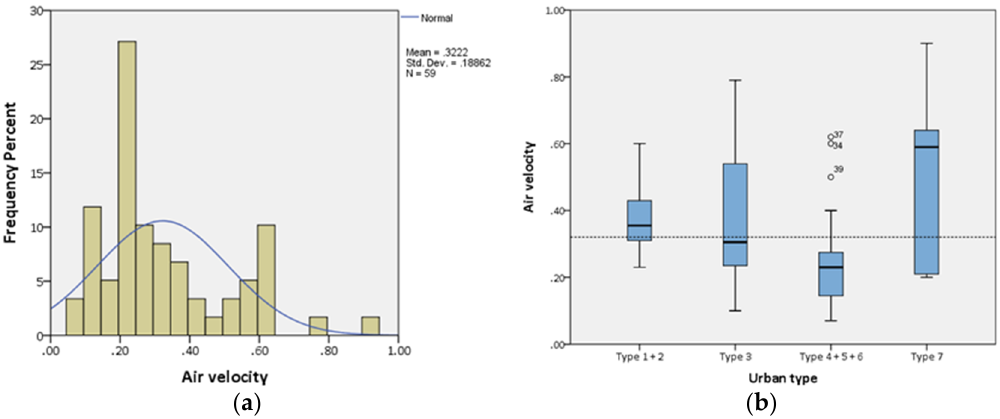
Figure 9. Air velocity shown as frequency distribution ( a ) and by variation in urban pattern type ( b ).